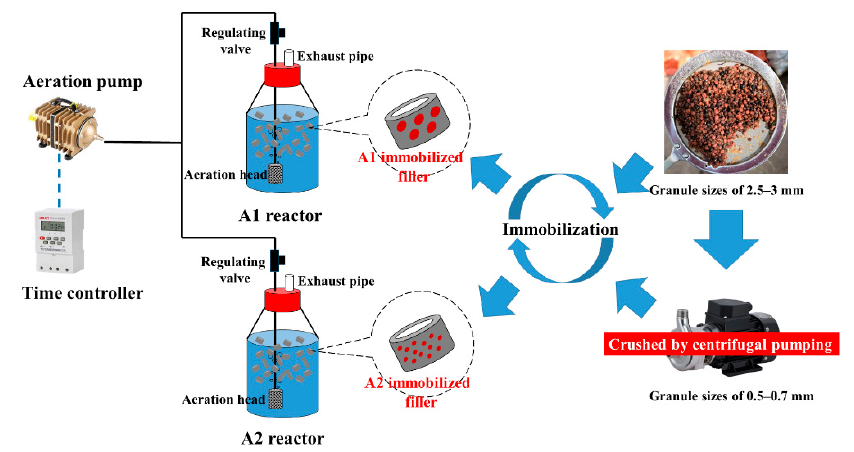
Figure 1. Schematic of the A1 and A2 immobilized filler reactors. Table 1. Characteristics of the domestic sewage after